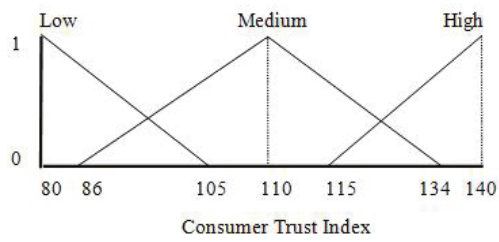
Fig. 4. Membership function for consumer trust index.